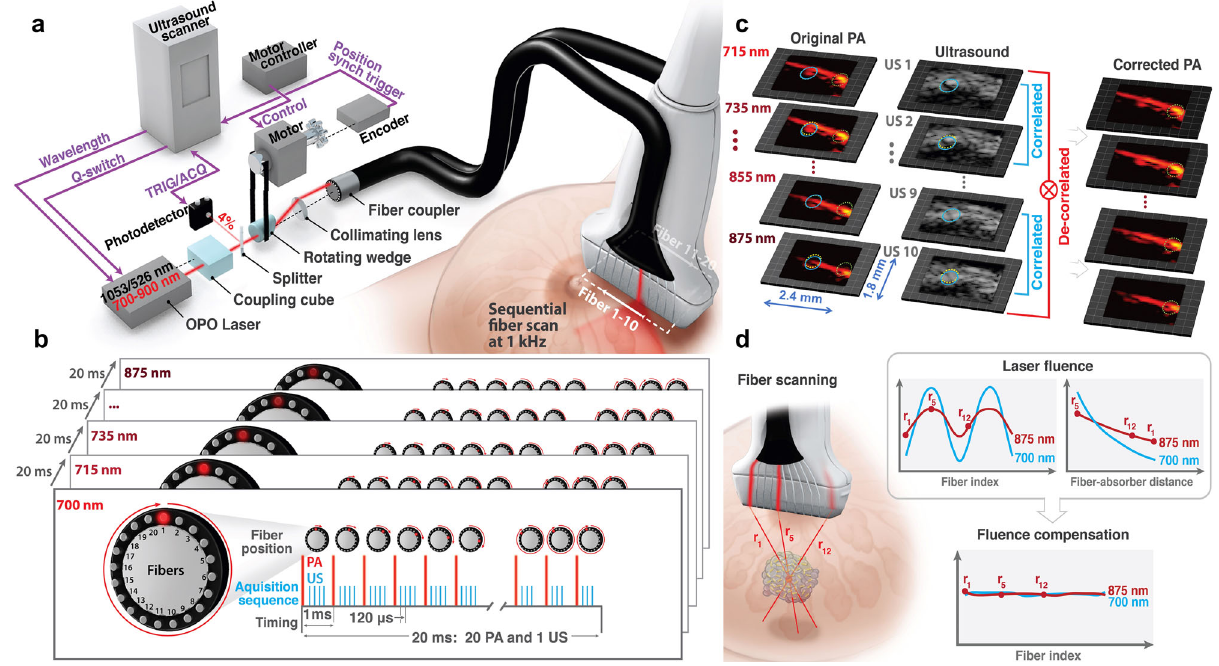
Fig. 2 A 50 Hz frame-rate spectroscopic swept-beam PAUS system with real-time compensation for wavelength-dependent fl uence and motion correction. a The PAUS system includes a kHz-rate, compact, wavelength-tunable (700 – 900 nm) diode-pumped laser (Laser-Export, Russia), an integrated fi ber delivery system (TEM-Messtechnik, Germany), and an US scanner (Vantage, Verasonics, WA, USA). The laser, externally triggered by the US scanner, emits pulses of about 1 mJ energy at a variable (up to 1 kHz) repetition rate, with wavelength switching times less than 1 ms. Thus, every laser pulse in a sequence can be at a different wavelength without sacri fi cing the kHz repetition rate. The integrated fi ber delivery system includes 20 fi bers arranged on two sides of a transducer array. The spinning motor rotates the laser beam over the ring, thus sequentially coupling laser pulses to different fi bers while sending a trigger signal to the US scanner. Upon triggering, the US system initiates the interleaved B and PA imaging sequence by sending a trigger to the laser. b Timing diagram and pulse sequence for interleaved, spectroscopic PAUS. Ten wavelengths (i.e., 700, 715 – 875 nm every 20 nm) are used. For each wavelength, the laser beam irradiates tissue sequentially from 20 fi bers, with several scanned, focused US beams interleaved for each laser fi ring. A frame composed of 1 B-mode and 20 PA sub-images is produced within 20 ms (50 Hz effective imaging frame rate). c The interframe tissue motion map is obtained using US speckle-tracking 56 , then applied to all pixels of co-registered PA images. Blue and yellow circles show local motion between adjacent frames, whereas a green circle fi xed in location clearly shows the ef fi cacy of motion correction. d Light emerging from different fi bers propagates different distances to a target. The amplitude of a partial PA image obtained for single fi ber irradiation follows the dependence shown in upper left plot. Considering the distance from each fi ber to a typical absorber in the imaging fi eld, the PA amplitude follows the form shown in the upper right plot due to light absorption and scattering in tissue. The procedure is repeated for all wavelengths